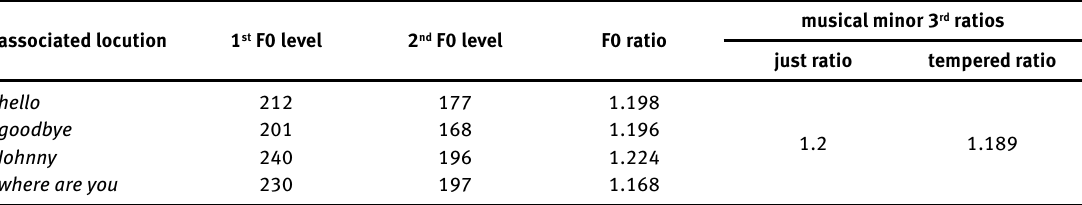
Table 2: Chant contour frequencies averaged over syllables and chant contour ratios compared with just and tempered minor 3rd (F0: fundamental